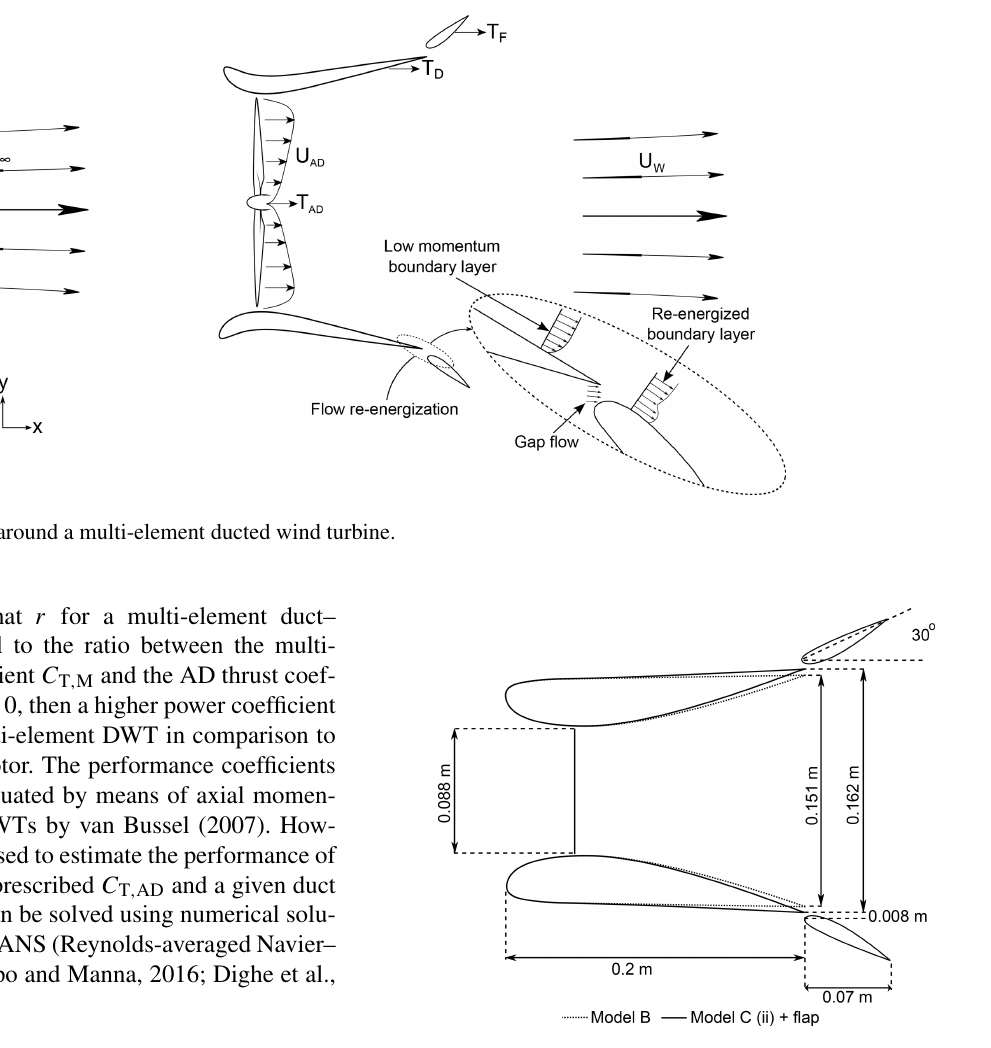
Figure 2. A schematic cross-sectional layout of the three- dimensional experimental model used for the numerical validation